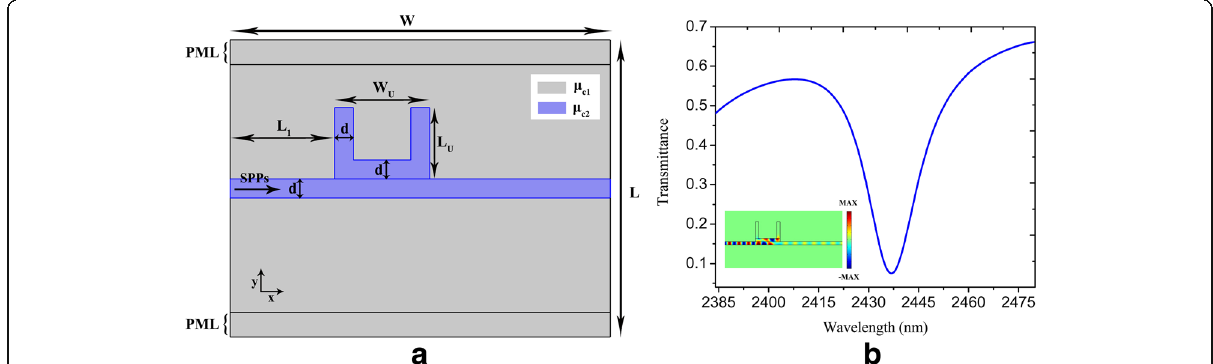
Fig. 1 a, b The schematic configuration and geometric parameters of a U-shaped nanocavity-coupled waveguide system and the corresponding spectral transmittance respectively. The inset in b shows the electric field ( E y ) distribution at a wavelength of 2437 nm. The parameters are set as W = 800 nm, L = 620 nm, d = 20 nm, W L L τ = 1 ps, μ μ U = 150 nm, U = 120 nm, 1 = 220 nm, c1 = 0.3 eV, and c2 = 0.9 eV. The perfectly matched layers ( PML ) with a width of 50 nm are implemented on the top and bottom of the computation domain to eliminate undesired reflections from the domain